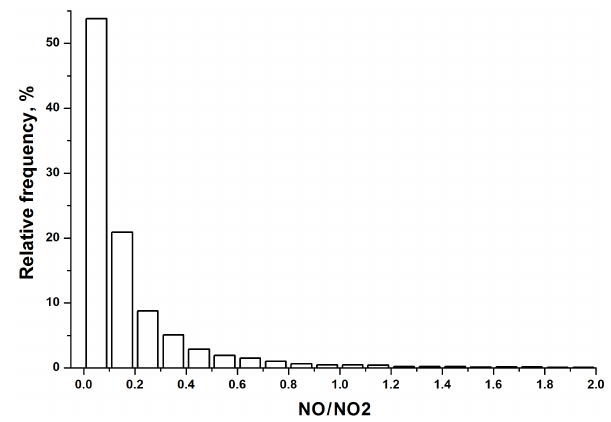
Figure 2. Relative frequency of NO / NO 2 values in the TROICA- 12